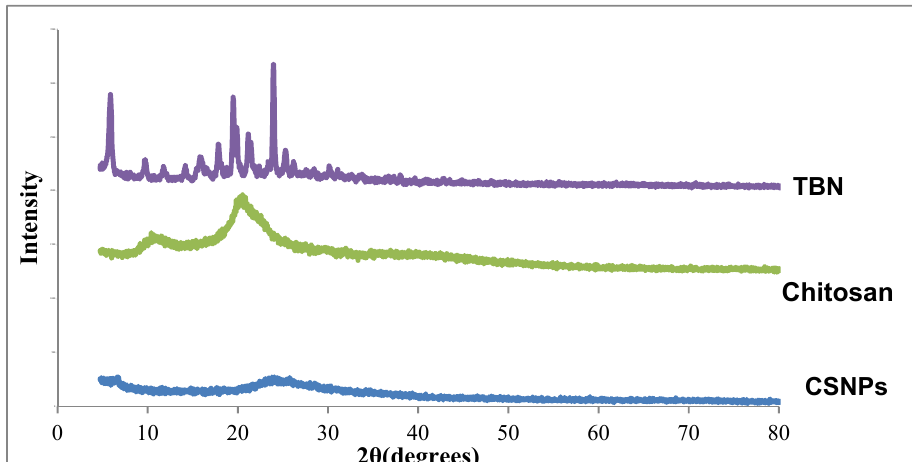
Figure 5. XRD Diffractrogram of TBN, Chitosan, and TBN-CSNP.